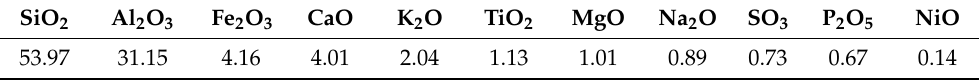
Table 3. Main chemical composition of fly ash